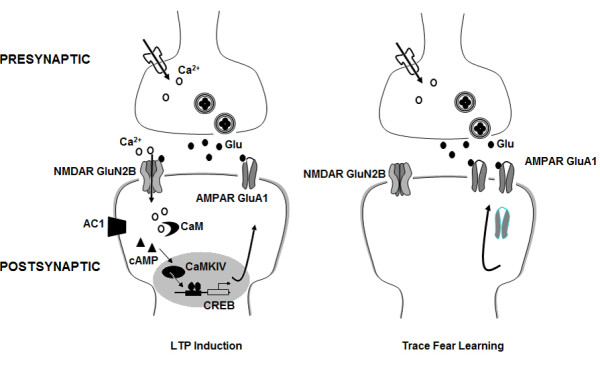
Rapid AMPAR upregulation contributes to trace fear learning. During trace fear conditioning, Ca2+ influx via NMDARs initiates AMPAR upregulation through activation of Ca2+/calmodulin-dependent protein kinase IV (CaMKIV) related pathways. Newly recruited postsynaptic AMPARs help potentiate glutamatergic excitatory transmission within the ACC, establishing plasticity in neuronal populations for long term memory storage.